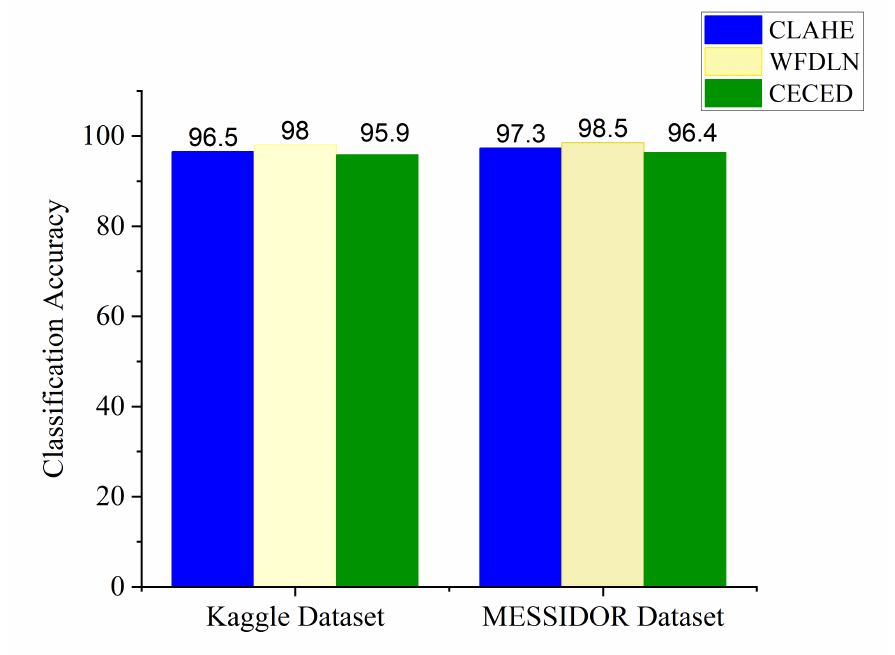
Figure 9. Classification accuracy for the single channels and the proposed WFDLN